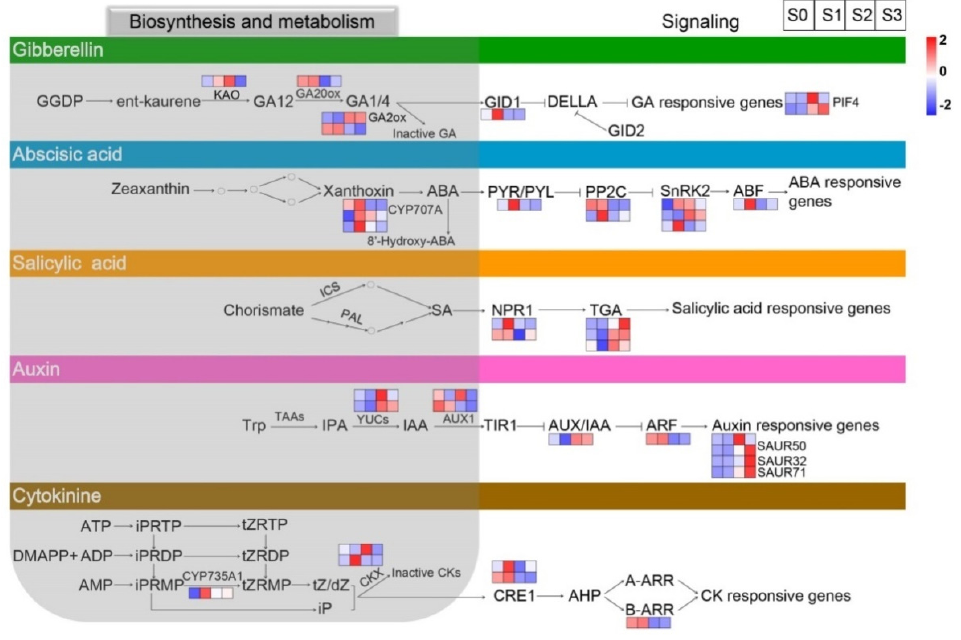
Figure 7. Heatmaps of differentially expressed genes (DEGs) related to plant hormone metabolism and signaling at the four statuses of spike formation of Phalaenopsis . From top to bottom, the five panels show DEGs involved in the GAs’, ABA’s, SA’s, auxin’s, and CTKs’ biosynthesis, metabolism, and signal transduction pathways, respectively. Red squares indicate upregulation, whereas blue squares indicate downregulation. The color scale corresponds to the average log 10 (FPKM+1) and Z-score (normalized by the R software) values. GA, gibberellic acid; ABA, abscisic acid; SA, salicylic acid; CTK, cytokinin; FPKM, fragments per kilobase of transcript per million mapped